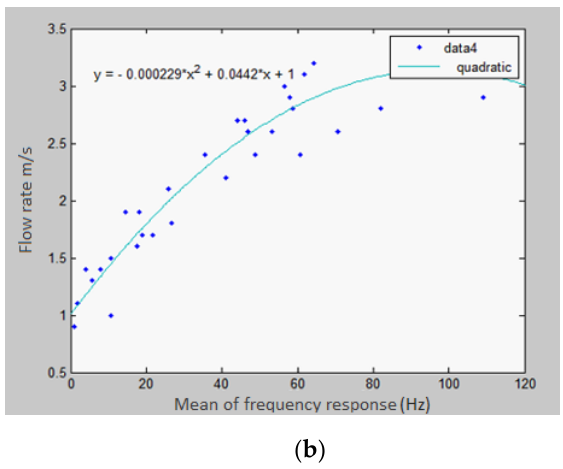
Figure 4. ( a ) Linear Regression. ( b ) Quadratic regression.